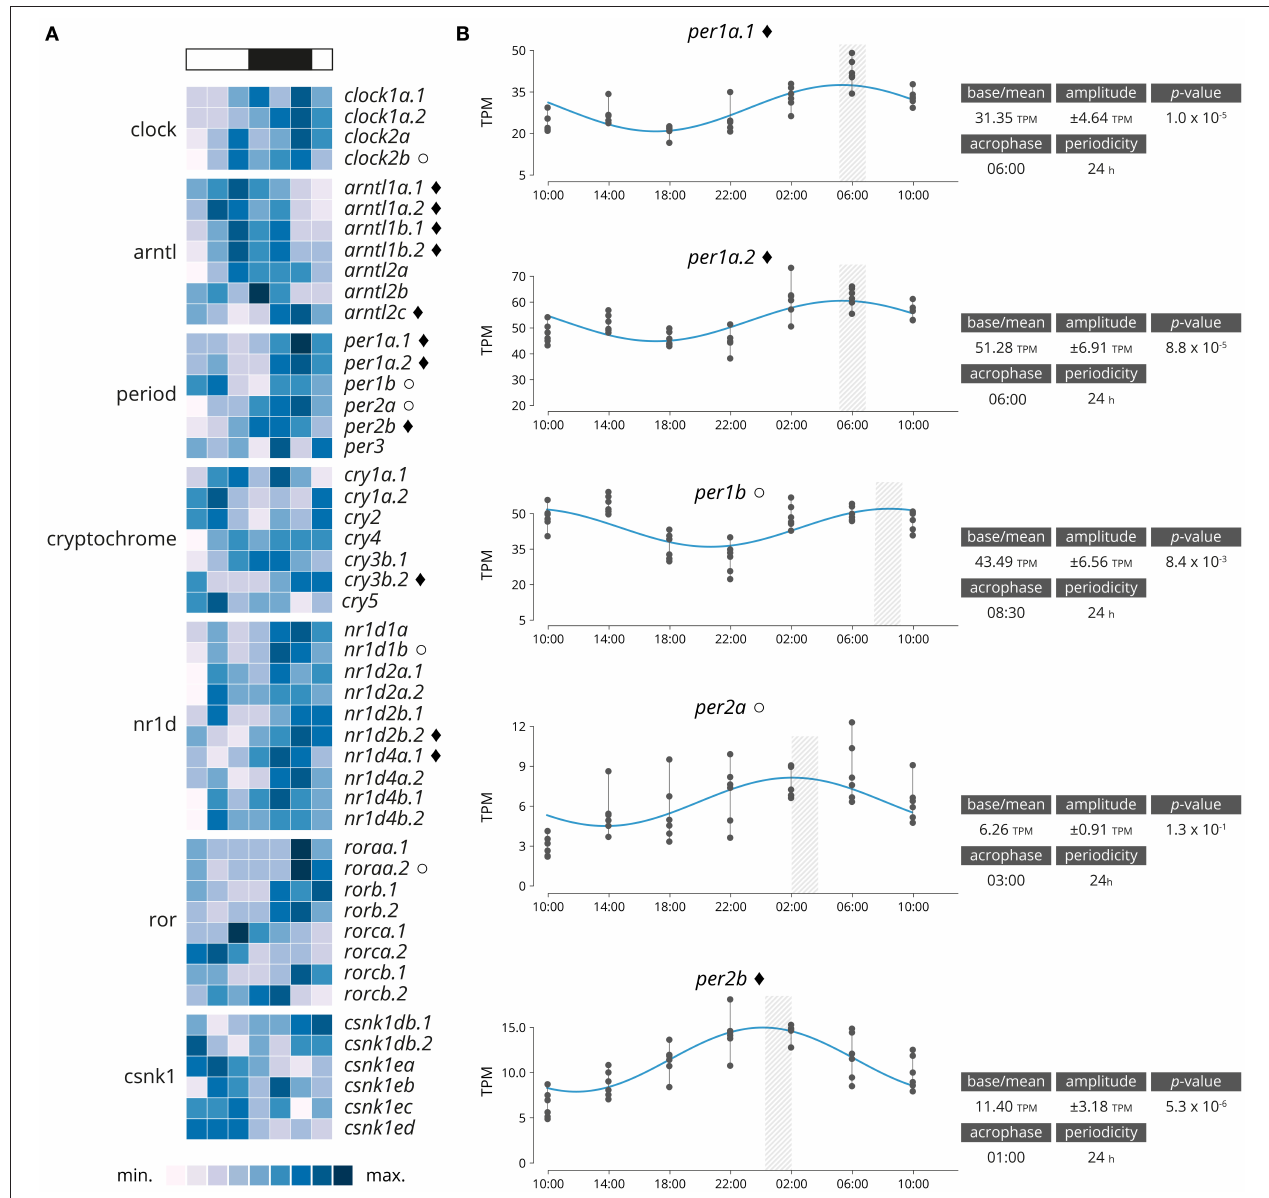
FIGURE 2 | (A) Heatmap displaying average diel expression of identified clock genes under constant LD (12:12, n = 6 per time point). The heatmap of the relative expression of each individual gene [scaled from lowest expression to highest expression]. Black diamond indicates significantly cyclic gene ( p < 0.001) [JTK and RAIN analysis], White circles denote rhythmic genes ( p < 0.001) [RAIN analysis]. (B) Significantly clock gene expression. Parameters of the cyclic sin-cosine function calculated by MetaCycle with JTK for diel expression of clock genes in brains collected from Atlantic salmon smolt exposed to an LD 12:12